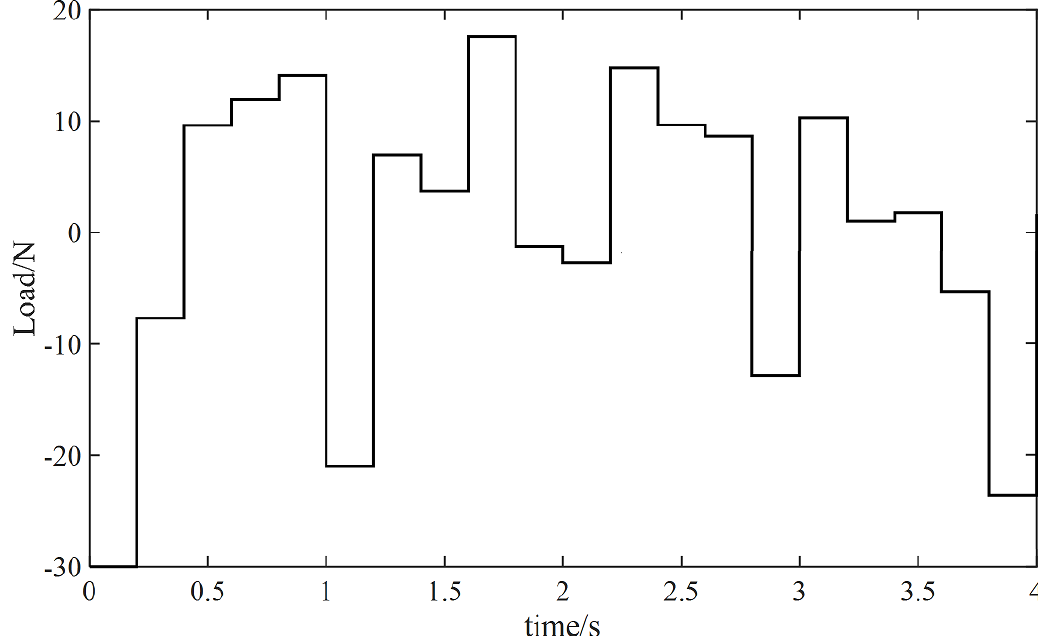
Figure 10. Random loads added to the three systems.